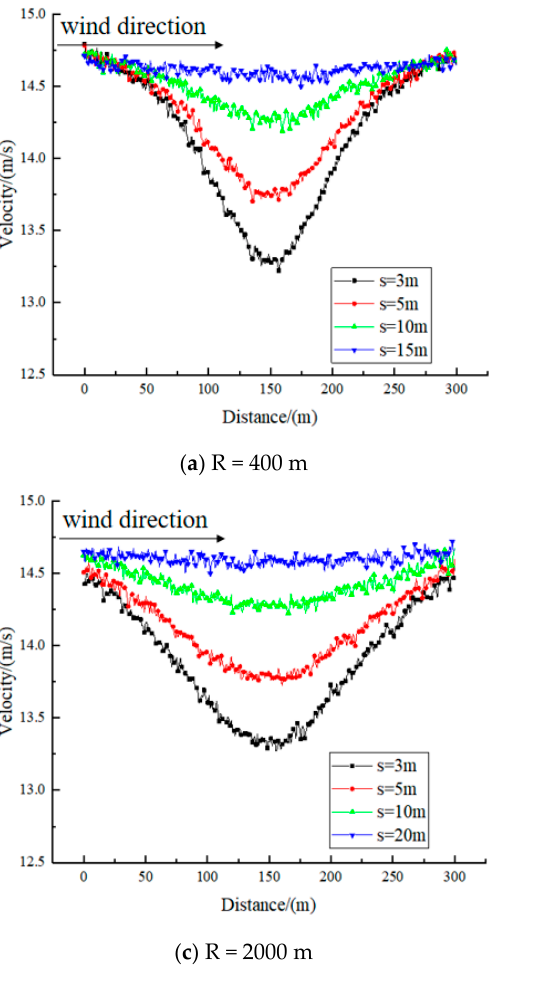
Figure 10. Wind-speed variation on the windward side of the Z = 1.5 m convex curve.